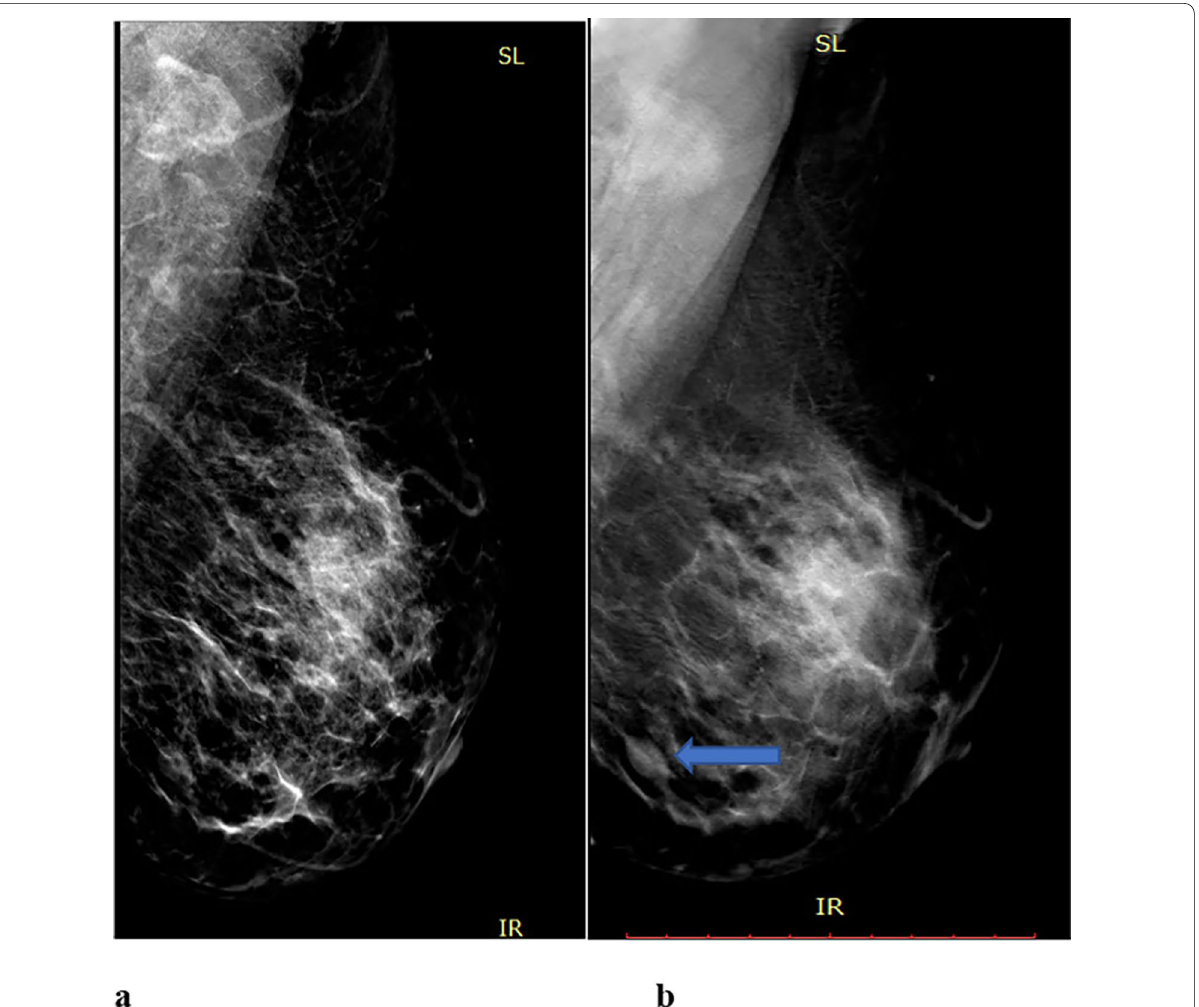
Fig. 2 A 48-year-old female complained of mastalgia in left breast. a MLO view of 2DDM of left breast shows heterogeneously dense breast (ACR c) with no abnormality detected. b MLO view of DBT of left breast shows circumscribed oval isodense mass in lower quadrant (BIRADS 3), proved by histopathology to be